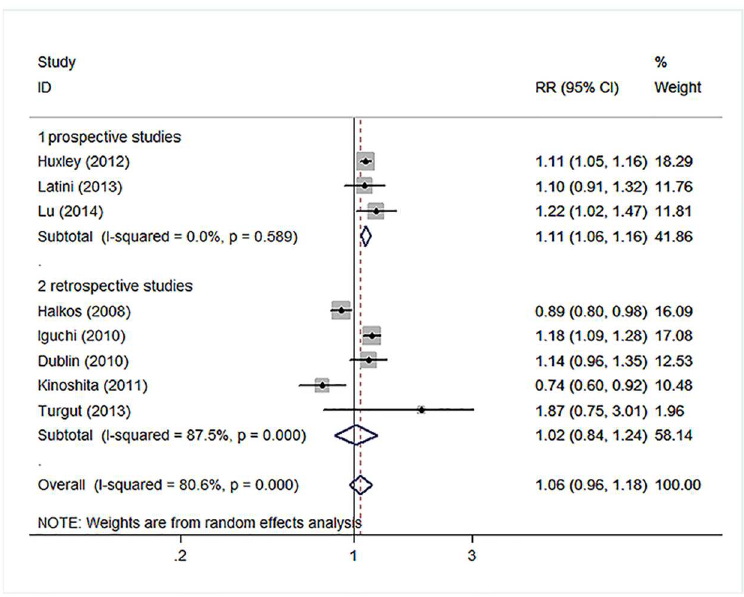
Fig 2. Forest plot demonstrating the association between HbA1c levels and AF depending on different study styles which HbA1c levels were analyzed as continuous variable. Relativerisks of AF for higherHbA1c comparedwith lower HbA1c. Squares indicatestudy-specific risk estimates (size of the square reflects the study-specific statistical weight, that is, the inverseof the variance); horizontallines indicate 95% CIs; diamondindicatessummary risk estimate with its corresponding 95% CI.